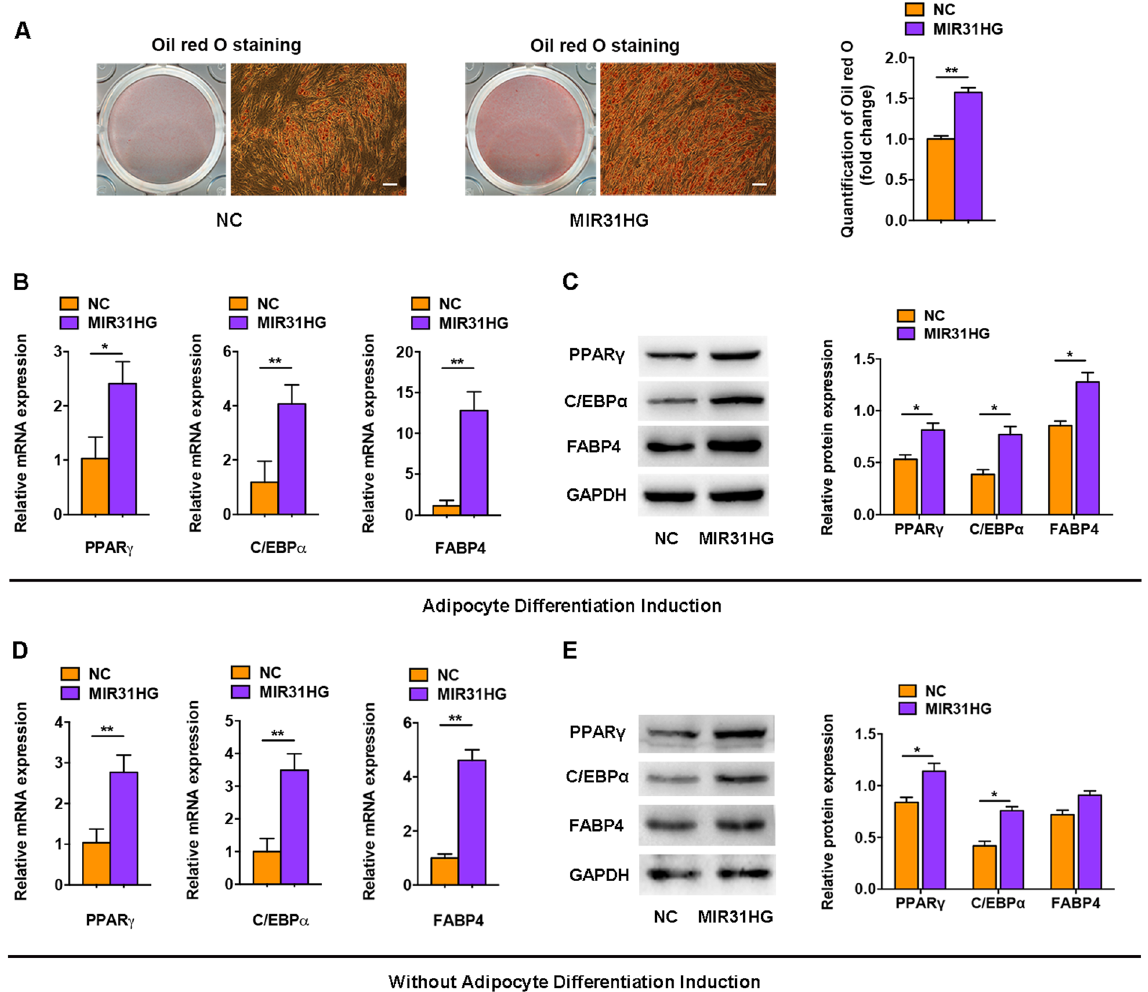
Figure 5. MIR31HG promoted adipogenic differentiation. The hASCs were transfected with lentivirus expressing MIR31HG or the scrambled vector (NC). ( A ) Images of Oil red O staining on day 8 of adipocyte differentiation. Scale bar, 100 μ m. Histograms show quantification of Oil red O staining by spectrophotometry (normalized to NC group). ( B ) Relative mRNA expression of the adipogenic genes PPAR γ , C/EBP α , and FABP4 on day 4 of differentiation. ( C ) Western blot analysis (left) and quantification (right) of protein expression of PPAR γ , C/EBP α , FABP4, and GAPDH on day 4 of differentiation. ( D ) Relative mRNA expression of the adipogenic genes PPAR γ , C/EBP α , and FABP4 without adipogenic differentiation. ( E ) Western blot analysis (left) and quantification (right) of protein expression of PPAR γ , C/EBP α , FABP4, and GAPDH without adipogenic differentiation. Data are presented as mean ± SD ( * P < 0.05, ** P <